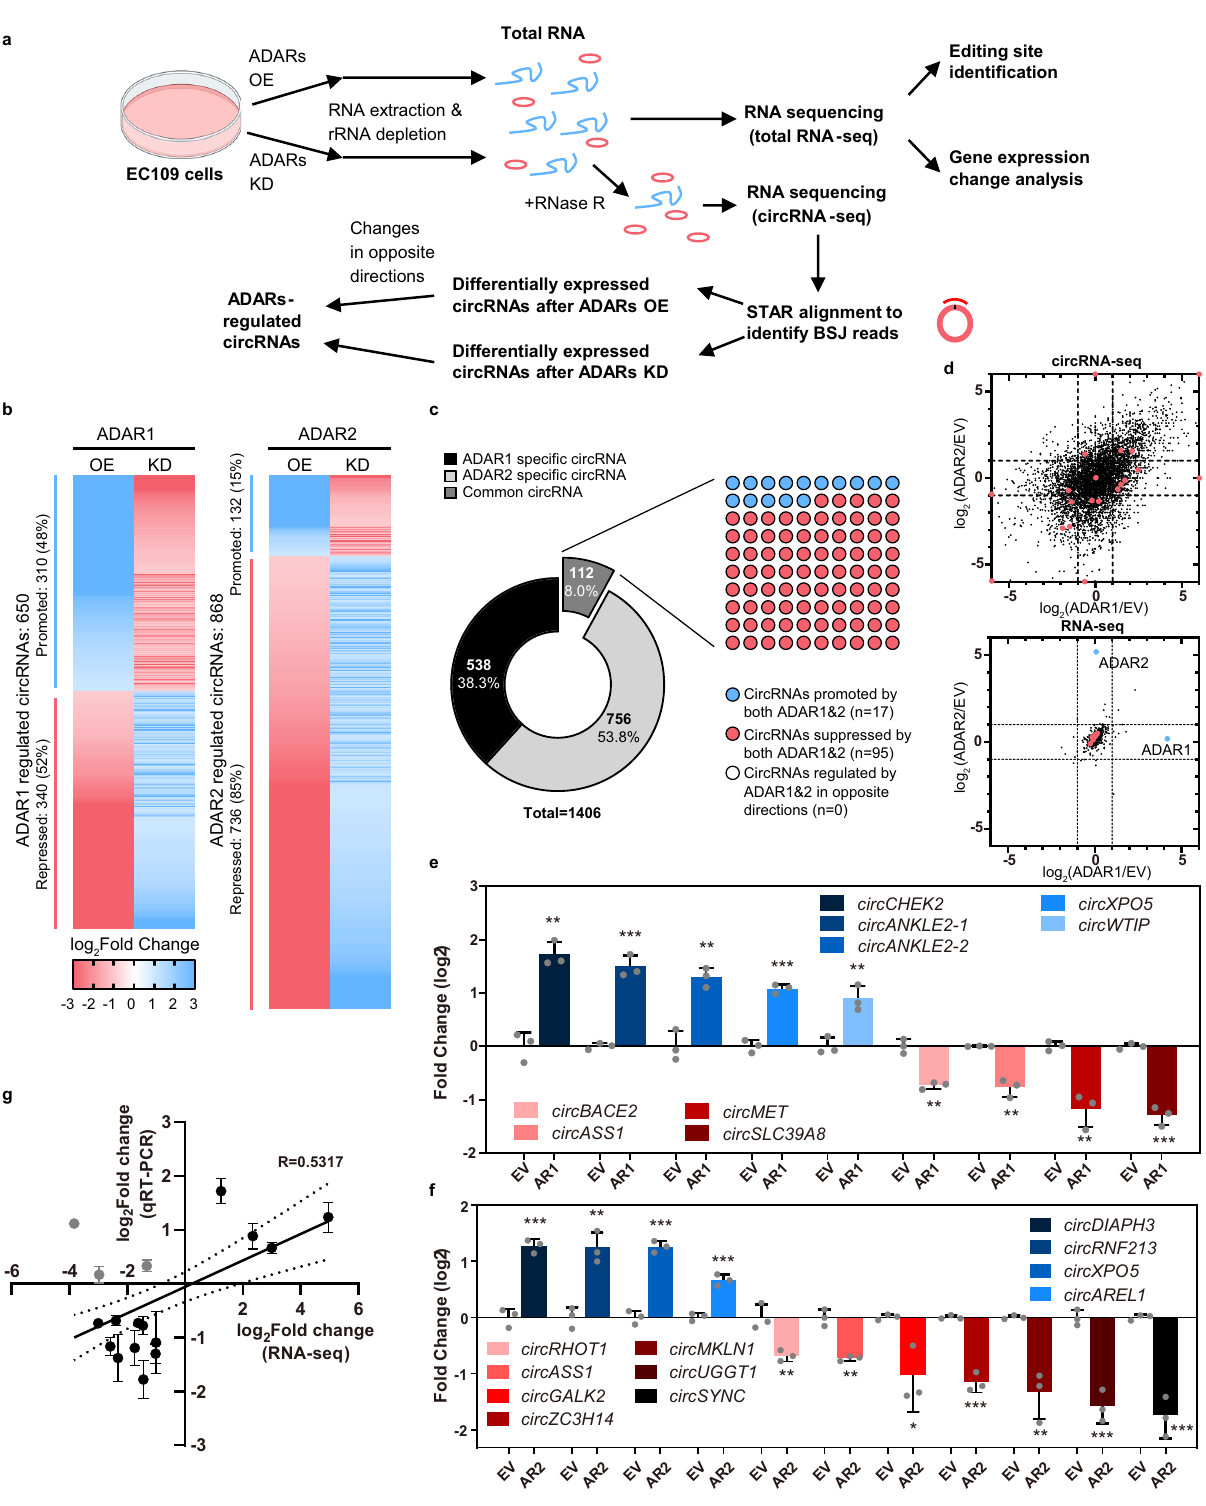
50-fold reduction in their expression; while circRNAs demon- strated strong resistance to the digestion, indicating that these candidate circRNAs are truly circularized RNA molecules (Supplementary Fig. 1d). Sanger sequencing analyses of puri fi ed circRNA products further con fi rmed these back-splicing events (Supplementary Fig. 1e). We then went on to validate the regulatory effects of ADARs on these candidate ARcircs identi fi ed by circRNA-Seq. Expression change was successfully veri fi ed for